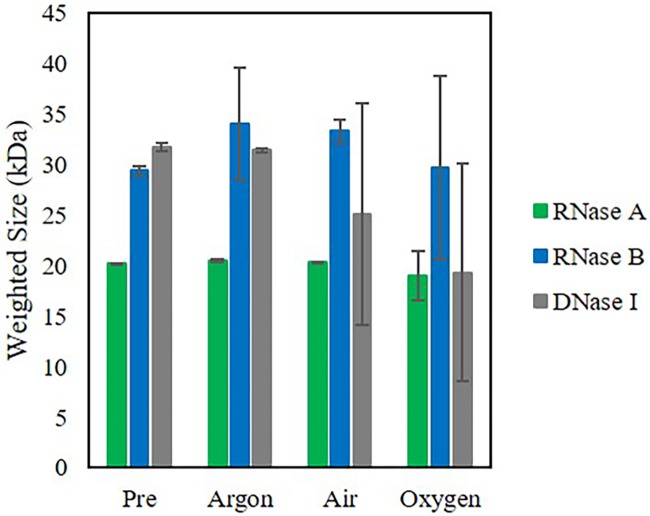
Weighted size (kDa) of RNase A, RNase B, and DNase I.Weighted size post purging and subsequent microwave irradiation of 30% power, 60 seconds. In general, as oxygen content increases, the overall weighted nuclease size decreases and the error in the size becomes larger. This in indicative of an increasing number of varying size fragments with an overall degraded nuclease. Pre = No microwave irradiation.